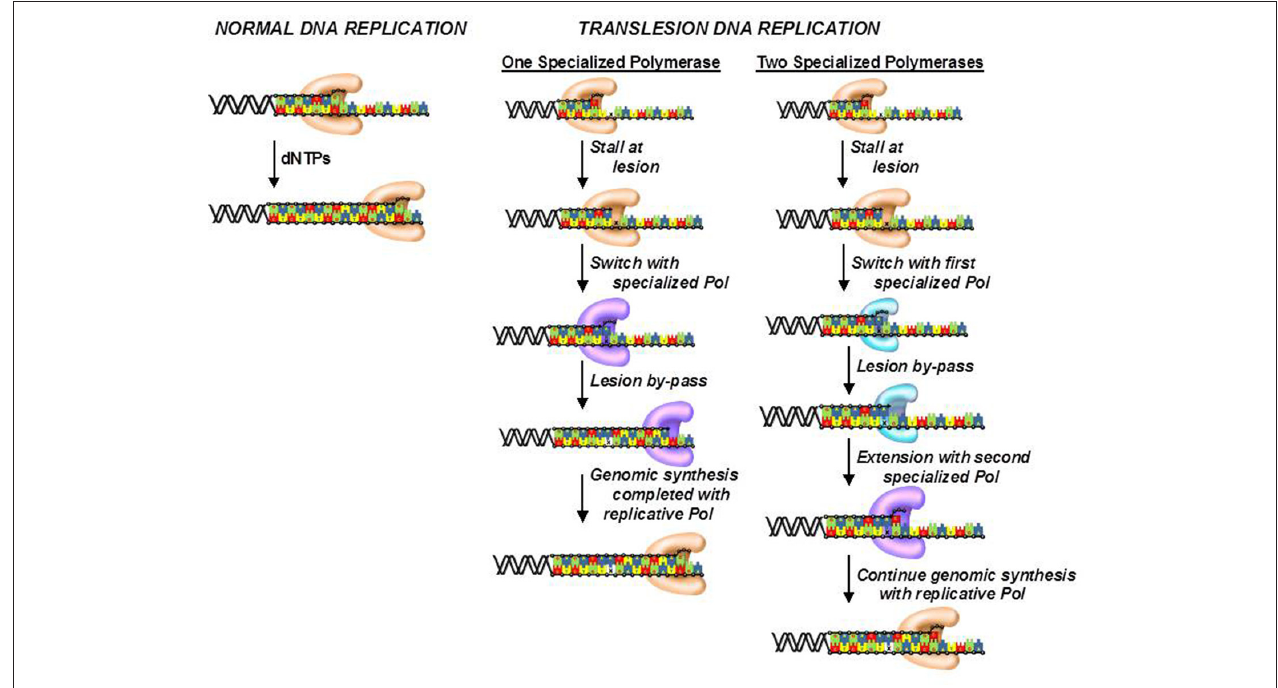
FIGURE 7 | Models for the efficient bypass of DNA lesions during translesion DNA synthesis. After encountering a DNA lesion, a replicative DNA polymerase incorporates a nucleotide opposite it but is unable to extend beyond the lesion. A specialized DNA polymerase extends beyond the lesion. Once the lesion is bypassed, the specialized polymerase is replaced by the replicative polymerase to resume processive DNA synthesis. In some cases, the replicative polymerase stalls at the DNA lesion and is unable to incorporate a nucleotide opposite the adduct. As a result, a specialized polymerase is recruited to the DNA lesion to incorporate a nucleotide opposite the lesion. A different specialized polymerase is then recruited for extension beyond the DNA lesion.